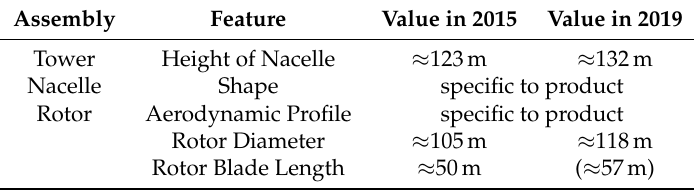
Table 1. Average sizes of on-shore wind turbines installed in Germany